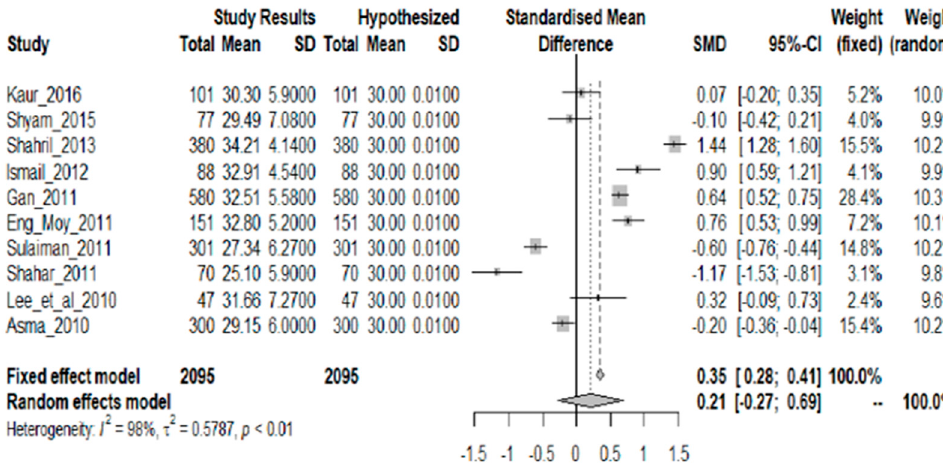
Figure 4. Meta-analysis of studies on fat intake of Malaysian Figure 4. Meta ‐ analysis of studies on fat intake of Malaysian adults.